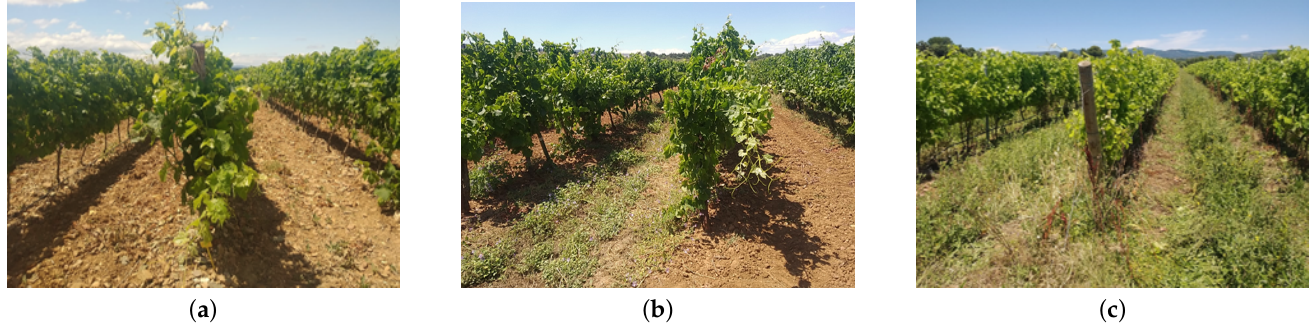
Figure 2. Location of the study vine plots for 2018, 2019 and 2020 and position of the corresponding S2 tiles. Plots were all about 1 ha in area and in majority ungrassed (67%) and are all managed in bilateral cordon with an inter-row distance of 2 or 2.5 m and an inter-vine distance of 1 m. An example of three inter-row management is given in Figure 3. Particular attention has been paid to choose plots with no evident sign of diseases such as esca, Black dead arm or chlorosis.